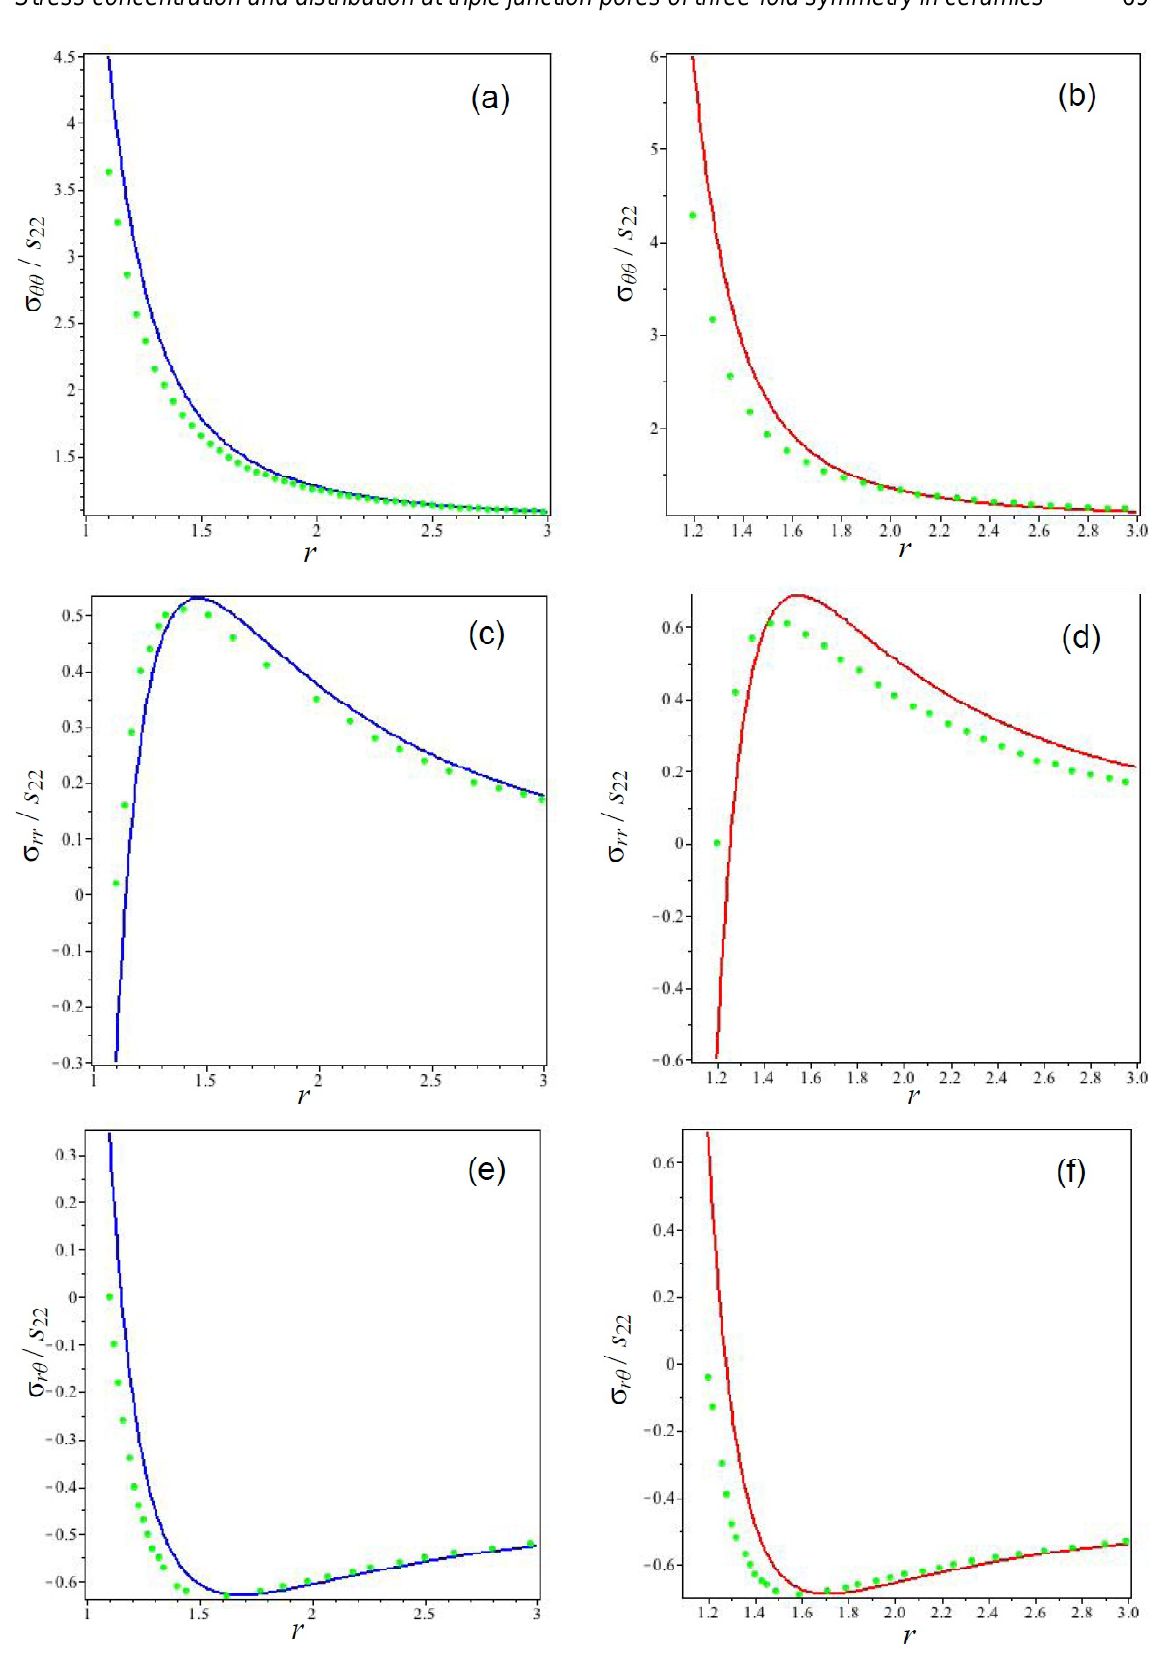
Fig. 6. Stress distribution along the lines (a–d) ( r >  ,  =0) and (e,f) ( r >  ,  =2  /3) for different values of  : (a,c,e)  =0.1 and (b,d,f)  =0.2. The stress components (a,b)  2  /3) were calculated numerically from the first-order approximation analytical solution (solid curves) and the finite element solution